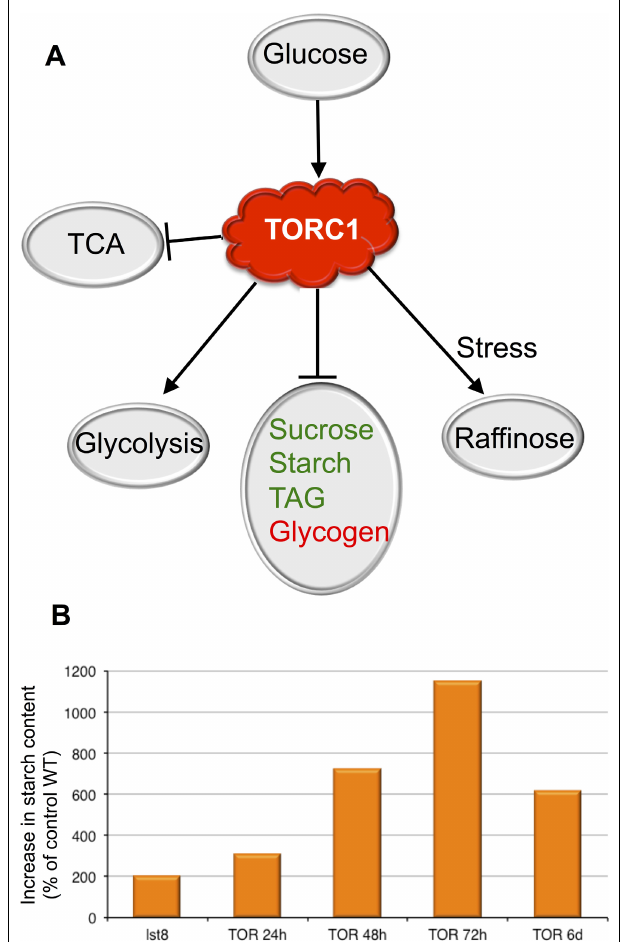
FIGURE 1 |The roles of theTOR kinase in the regulation of C metabolism. (A) Summary of the cross-talk between theTORC1 signaling pathway and the sugar metabolism. Glucose seems to induceTOR activity, which in turn activates glycolysis and raffinose synthesis in response to stresses. ConverselyTOR represses the synthesis of reserve molecules. Animal reserve compounds are in red, plant ones are in green. Activation is shown by arrows. (B) Accumulation of starch following inactivation of the TORC1 complex in percentage of the control wild-type (WT).The effect of the inactivation of theTORC1 component LST8 on starch accumulation was investigated in insertion mutants. Results from the analysis of lst8 mutants are from Moreau etal. (2012) and are compared to the corresponding controlWT (Col8). A time-course experiment shows the accumulation of starch following inactivation ofTOR by ethanol-inducible RNAi (24–72 hours (h) after ethanol induction; Deprost etal., 2007).The 6 days (6d) point is from Caldana etal. (2013) using estradiol-inducible amiRNA